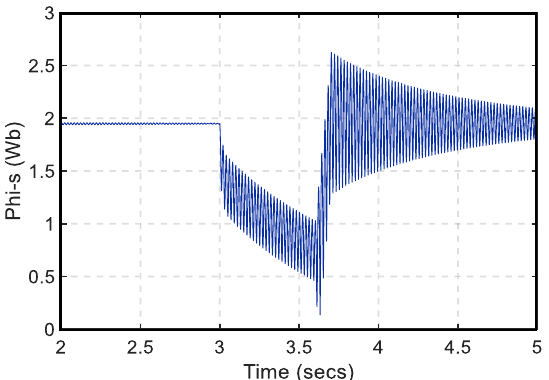
Fig. 9 Stator flux